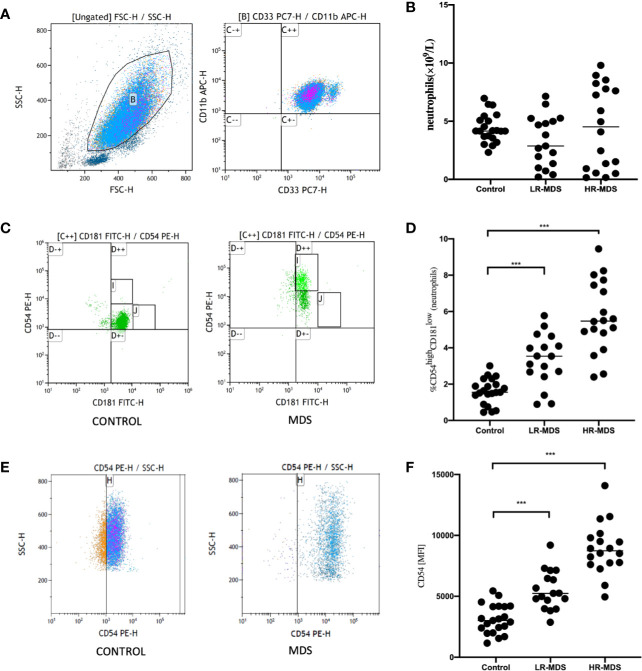
Increased frequency of CD54highCD181low neutrophils cells in the peripheral blood of new diagnosis myelodysplastic syndromes (MDS) patients. (A, B) Frequency of peripheral blood neutrophils were compared between 23 healthy controls (HC) and 37 new diagnosis MDS patients. FSC and SSC were used to gate neutrophils. CD33 positive and CD11b positive were used to confirm neutrophils (C++). (C, D) Representative dot plots from flow cytometric (FACS) analyses showing the CD54highCD181low cell frequency among peripheral blood neutrophils obtained from HC (n = 23) and MDS patients (n = 37) (I represents CD54highCD181low neutrophils). (E, F) Mean fluorescence index (MFI) levels of CD54 on the CD33 and CD11b neutrophils was compared between HC (n = 23) and MDS patients (n = 37). The bars represent the standard error of the mean. ***P < 0.001.